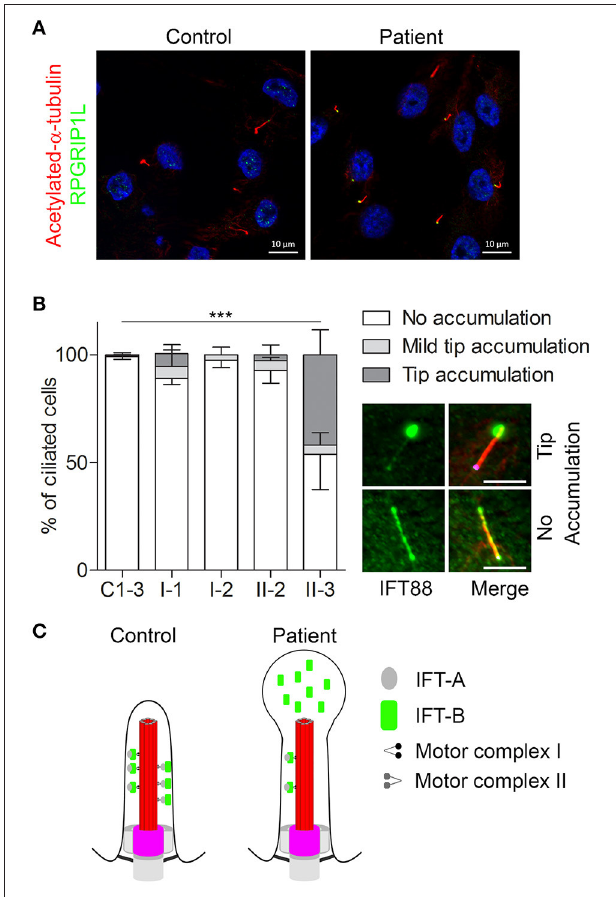
FIGURE 4 | Defective retrograde transport in urine-derived cells from a Mainzer-Saldino syndrome patient. URECs derived from a patient (referred to as “patient” or “II-3”) with compound heterozygous variants in IFT140 (one pathogenic frameshift and one missense variant of uncertain significance), were compared to URECs from three control individuals (C1-3). (A) URECs stained for ciliary marker acetylated- α -tubulin (red) and RPGRIP1L (green). (B) Analysis of retrograde transport in controls, healthy family members (I-1, I-2, and II-2) and patient (II-3) URECs. Cilia were visualized with acetylated- α -tubulin (red) and RPGRIP1L (pink). The cells were analyzed for the presence of IFT88 (green) accumulation at the ciliary tip. Patient II-3 showed a significant tip accumulation of IFT88 in 41% of the cells (Fisher’s exact two-tailed test showed a p < 0.0001 when comparing the cells of the patient to those of the controls). Scale bar represents 5 µ m. (C) A schematic overview of the cilium in controls and in the patient with pathogenic variants in IFT140 . The control shows normal intraflagellar transport with the IFT-B complex transporting proteins from the base of the cilium to the tip (axoneme is shown in red and the transition zone marks the base of the cilium in pink) and the IFT-A complex transporting proteins back down to the base. The image shows defective retrograde transport leading to an abnormal bulge at the ciliary tip, which is filled with IFT-B proteins. This image was adapted from Oud et al. (19).